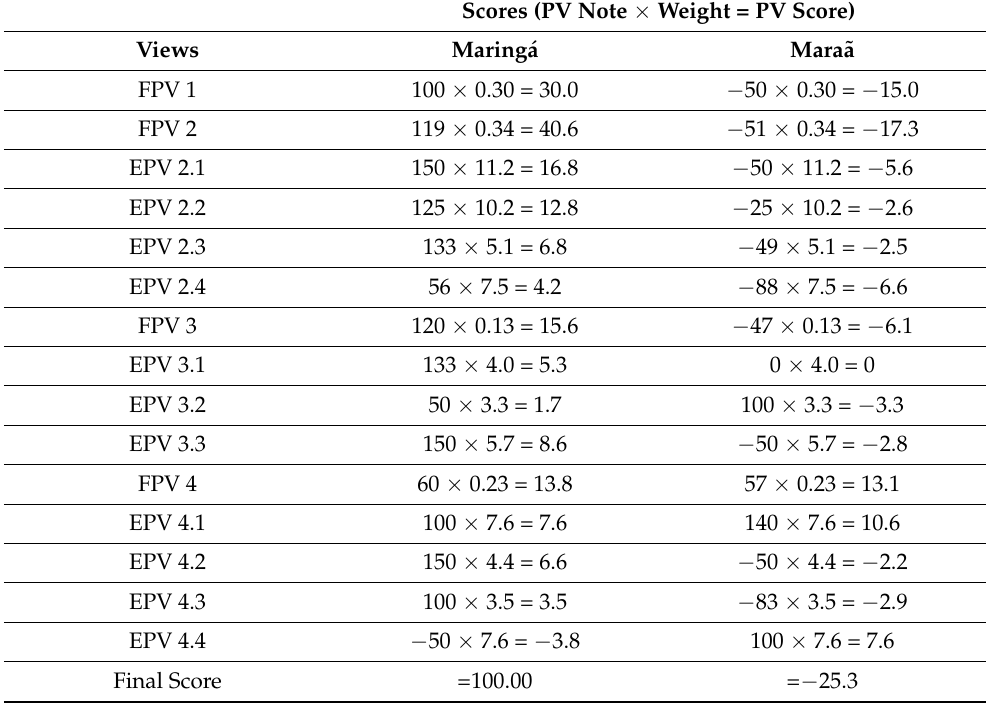
Table 9. Methodology for calculating locality scoring.